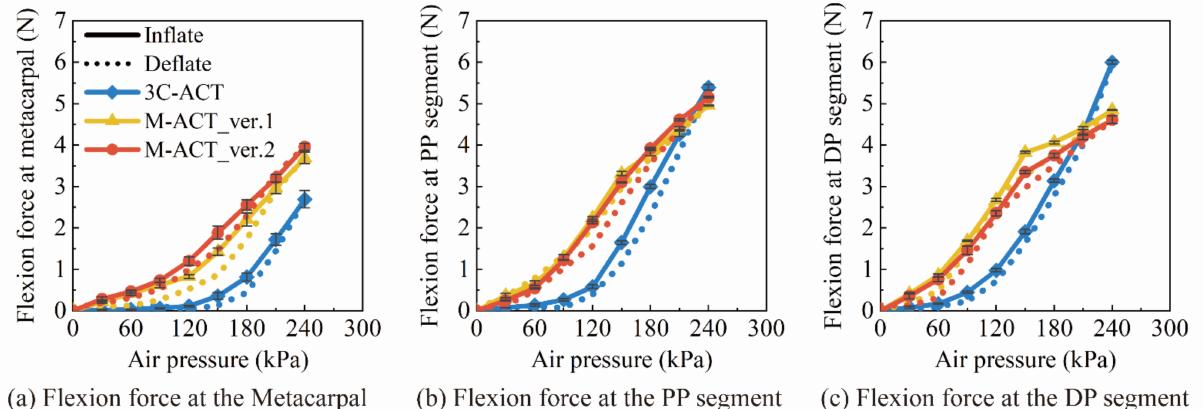
Figure 5. Flexion force output. PP: proximal phalanx; DP: distal phalanx.